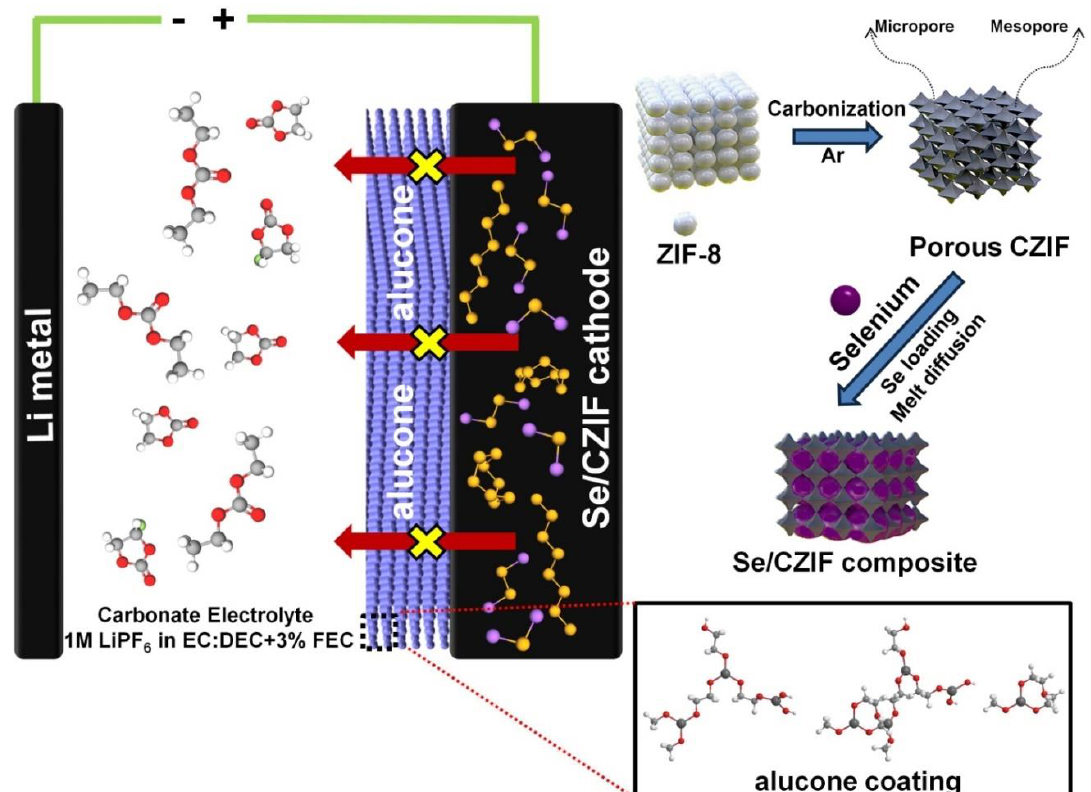
Figure 1. Schematic illustration for the preparation of the Se/CZIF − alucone coating.